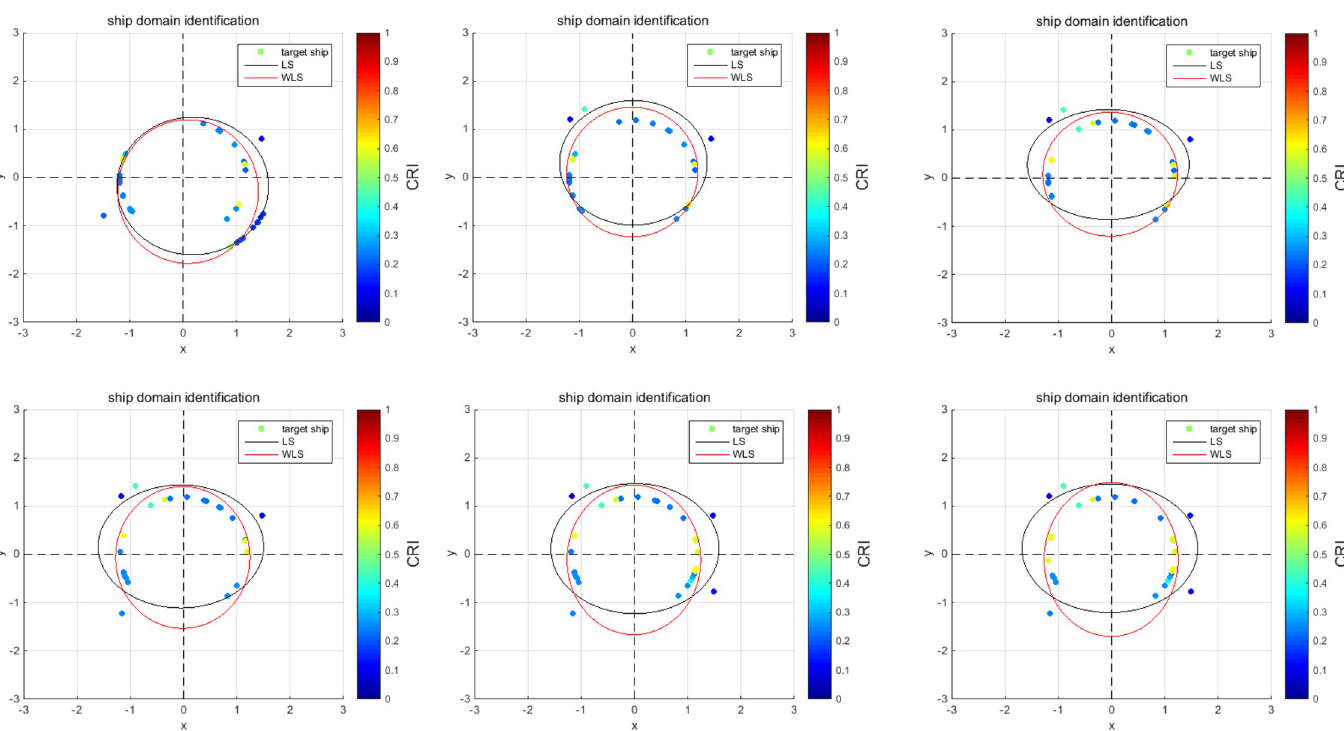
Fig 9. Online rolling identification results of the ship domain. (T1) Identification results at Time T1, correspondingly, � CRI � ¼ 0 : 28 ; (T2) Identification results at time T2, correspondingly, � CRI � ¼ 0 : 30 ; (T3) Identification results at time T3, correspondingly, � CRI � ¼ 0 : 35 ; (T4) Identification results at time T4, correspondingly, � CRI � ¼ 0 : 32 ; (T5) Identification results at Time T5, correspondingly, � CRI � ¼ 0 : 35 ; (T6) Identification results at Time T6, correspondingly, � CRI � ¼ 0 : 38 .